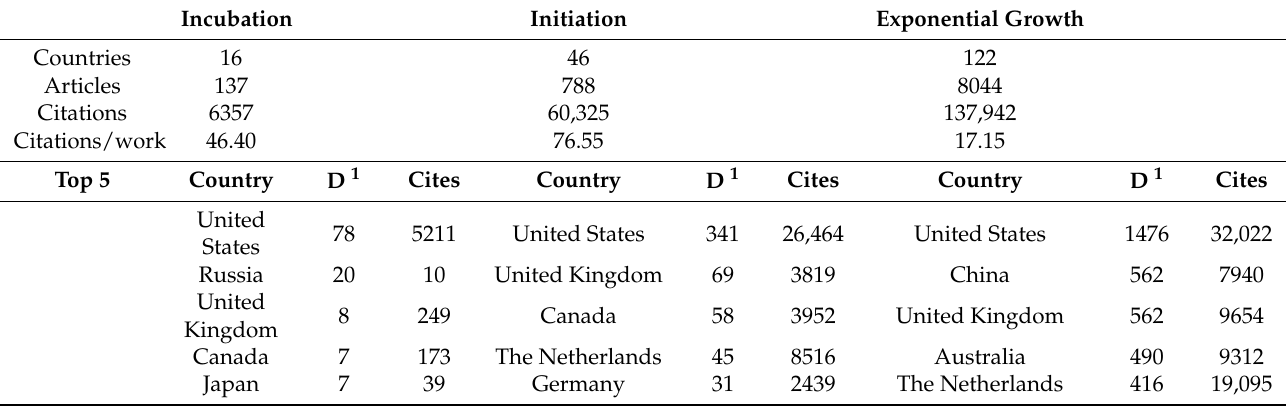
Table 1. Top 5 countries, papers, and citations in the three temporal periods.